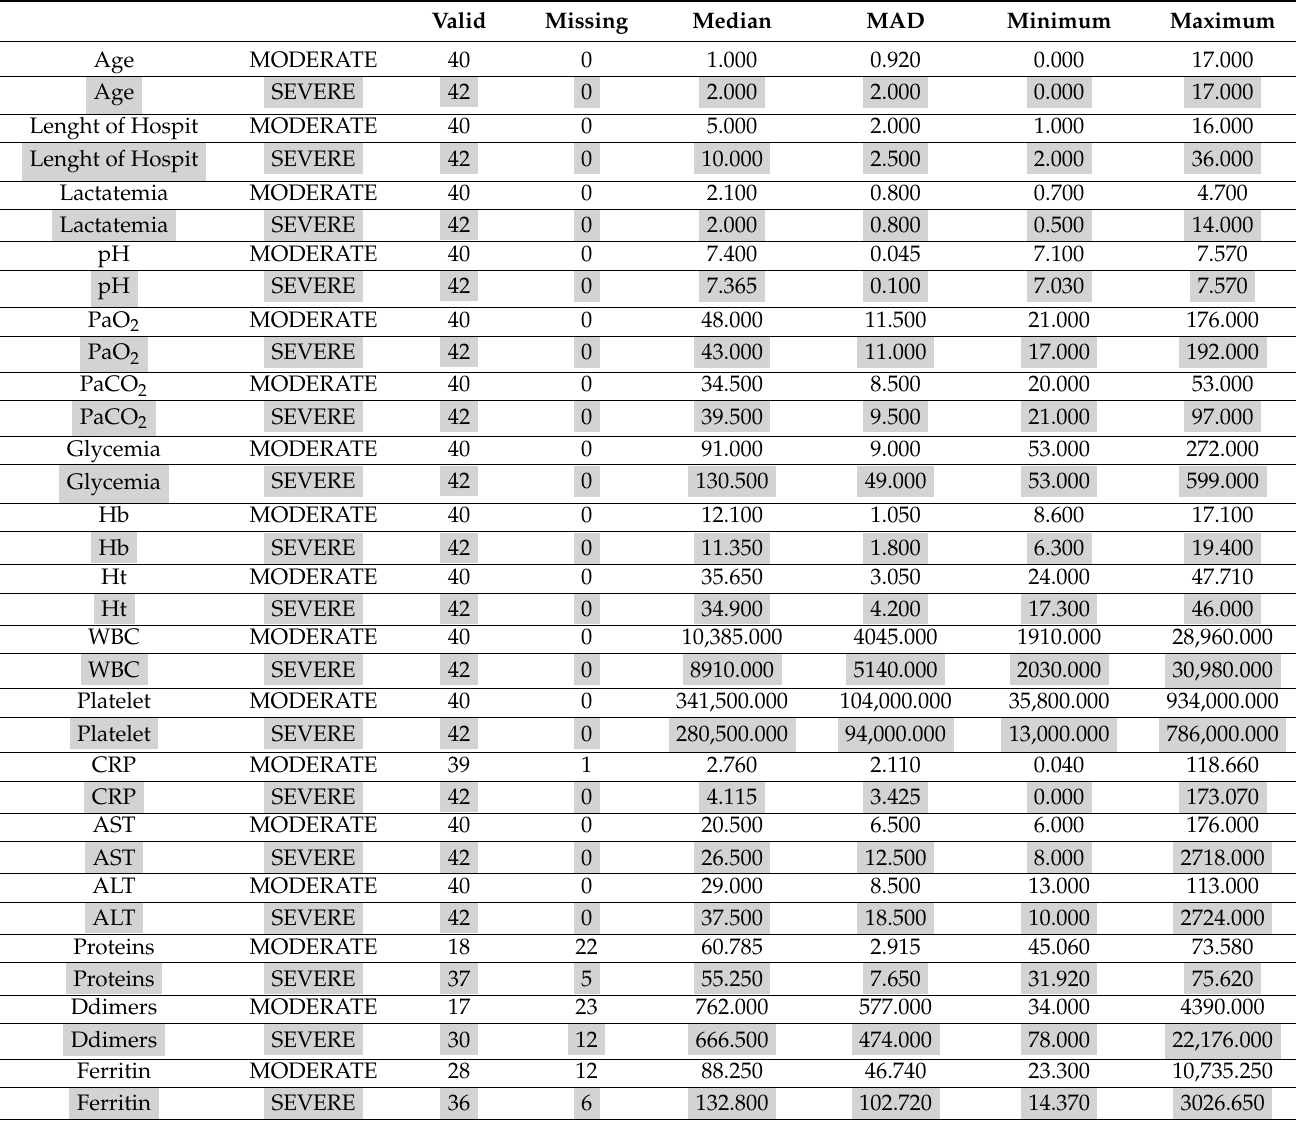
Table 1. Descriptive Statistics depending on the severity of the